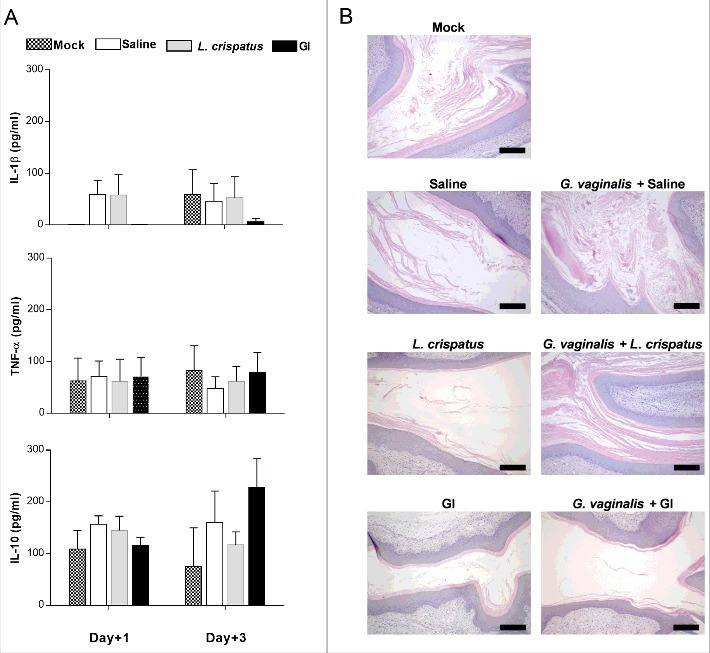
Evaluation of immune response to probiotic treatment. (A) Pro-(IL-1β and TNF-α) and anti-(IL-10) inflammatory cytokines levels have been determined in vaginal washes of mice, treated intravaginally with 10 μl of Saline, or L. crispatus (2 × 109/ml) or GI (108/ml) and infected with G. vaginalis (5 × 107/20 μl/mouse), at days +1 and +3 post-infection. Data are the mean ± SEM from 2 independent experiments each with 6 mice/group. (B) Histological inflammation was assessed by haematoxylin-eosin staining of formalin-fixed, paraffin-embedded vaginal tissue sections. Images (Bar = 200 µm, Magnification 10x) are representative of 2 separate experiments with similar results.